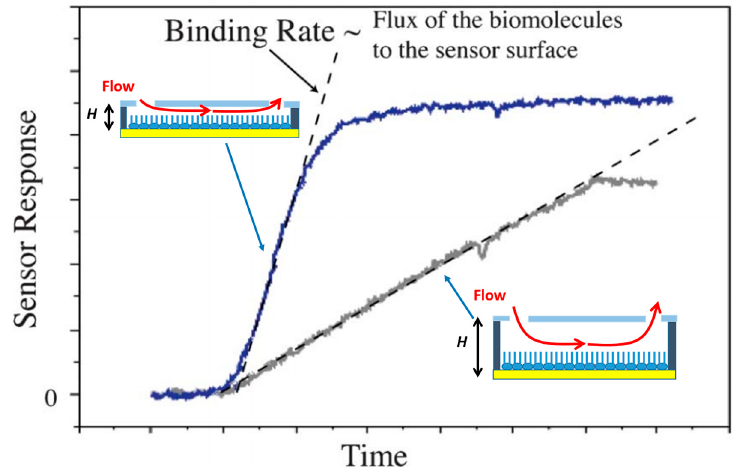
Figure 6. Typical sensor response vs. time; the blue and grey data sets represent higher and lower flux of target analyte, respectively. The slope of the time-series response is proportional to the flux of analyte to the sensor surface. Reprinted with permission from [57]. Copyright 2013 The Royal Society of Chemistry.